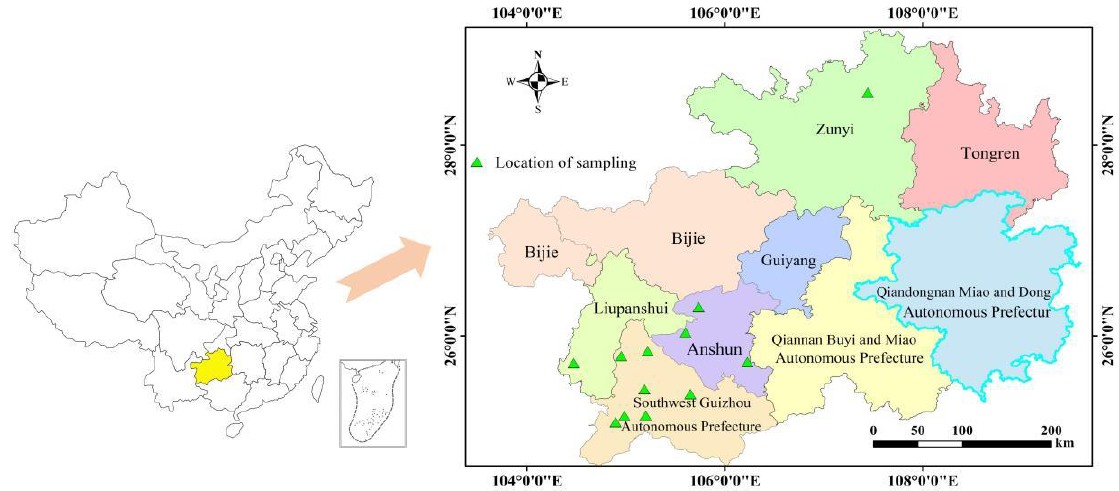
Figure 1. The distribution of sampling sites.